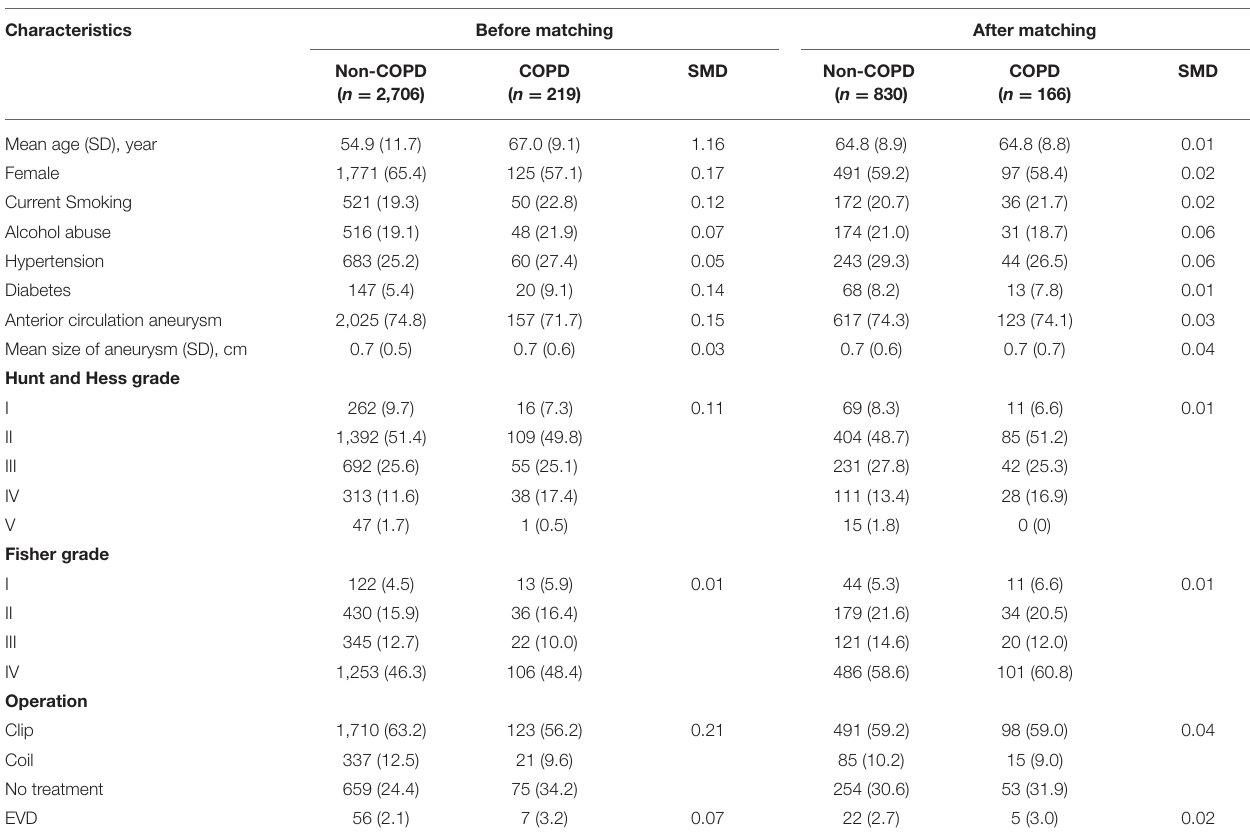
TABLE 1 | Baseline characteristics of the patients by COPD.